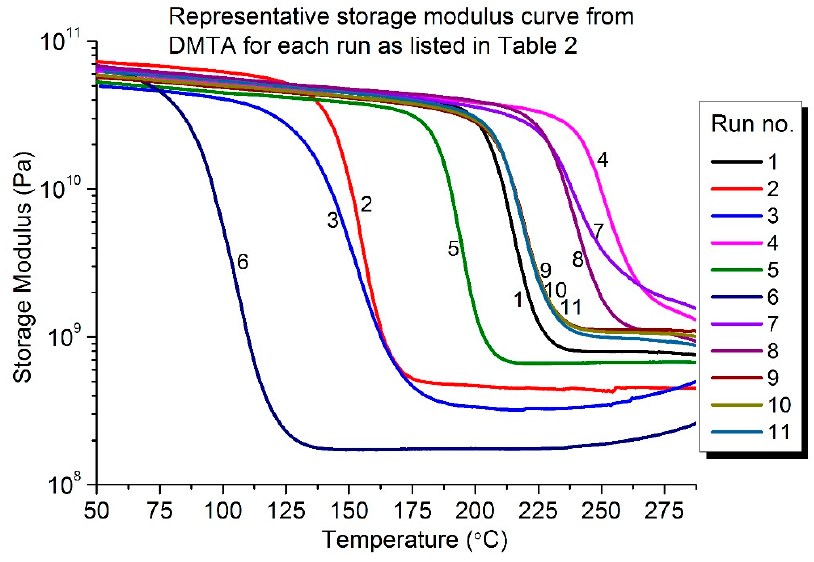
Figure 8. Representative storage modulus curve from DMTA for each run, as listed in Table 2. The effect of BPF content and the stoichiometry ratio on the value of T g is shown in Figure 10. As seen in the 3D and contour plots of surface response, T g increases as the amount of TGPAP epoxy increases in the epoxy blend (factor A). For example, at a fixed stoichiometry ratio of 0.42, T g increased by 336% when the TGPAP increased from 12.5% to 95% in the epoxy blend (Figure 10b). This is due to the fact that TGPAP has a higher functionality compared to a bifunctional epoxy such as BPF, resulting in a greater crosslink density. Therefore, a higher T g was obtained in the epoxy blend with a higher amount of